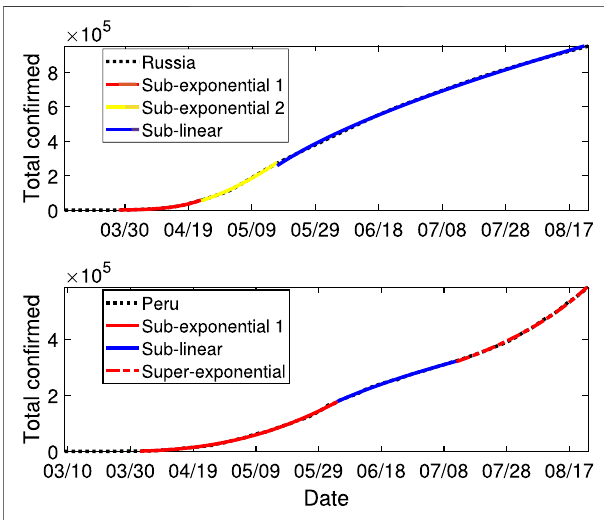
FIGURE 4 | The fi tting results of Russia and Peru. The black dashed curves represent the real data. The red and yellow curves represent two different sub-exponential growth of the total con fi rmed cases over time. The blue curve represents the sub-linear growth. The red dashed curve represents the super-exponential growth in the third stage of Peru. The parametersanddatesinconsiderationfordifferentcasesarelistedin Table1 .